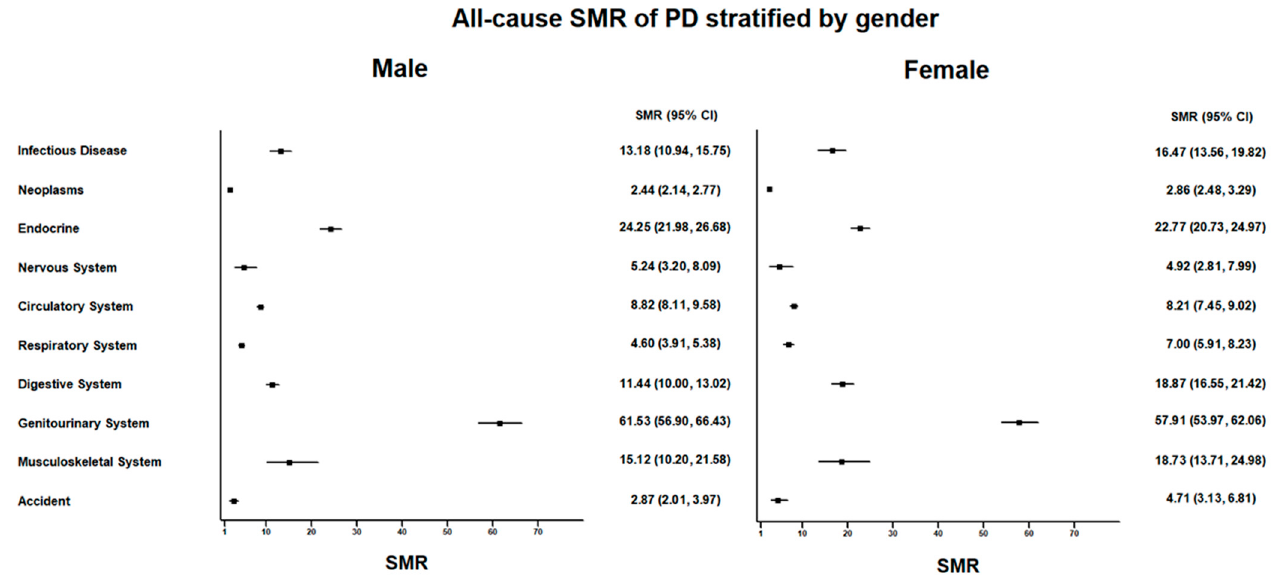
Figure 2. All-cause standardized mortality ratio (SMR) of peritoneal dialysis (PD) patients stratified by gender.